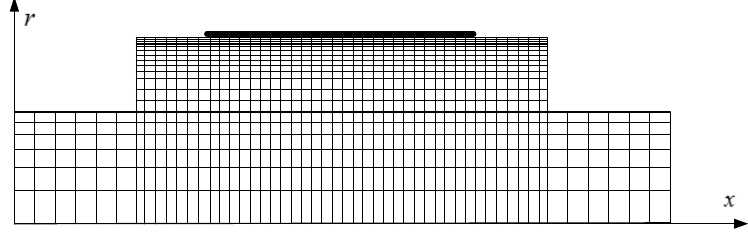
Figure 3. The mesh generation of roll temperature field.